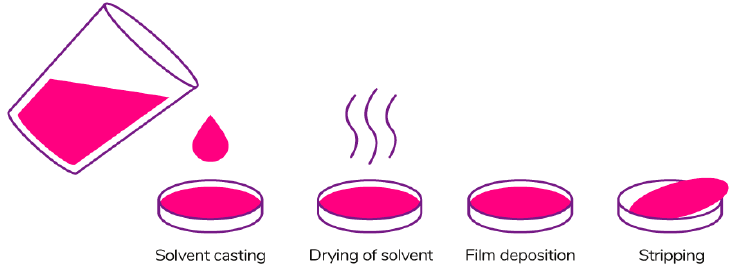
Figure 11. Casting method [186]. Reproduced with permission from Suhag, R., et al., Food Research International; published by Elsevier Ltd., 2020.